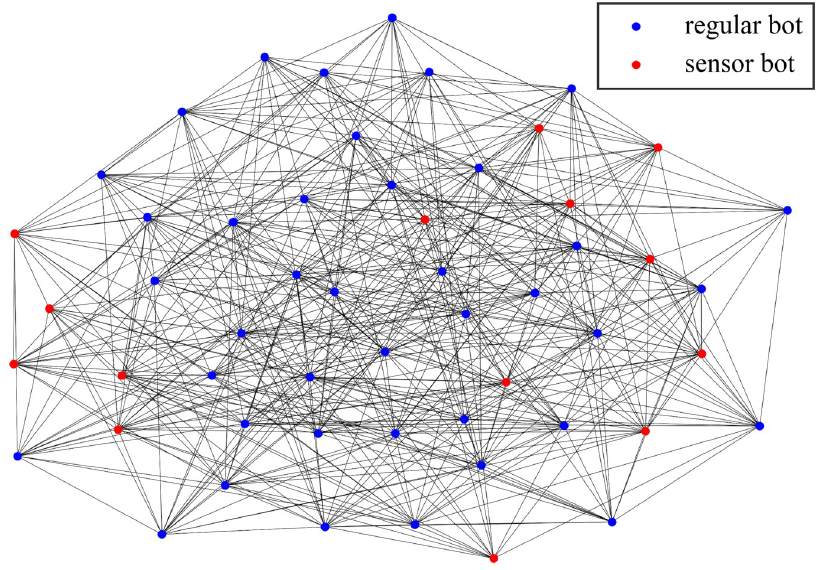
Fig 7. A network overview of the pre-constructed P2P botnet deployed on cloud platforms. overview of the simulated botnet, red dots represent sensor bots, and blue dots represent regu- lar bots. Fig 6 shows that all the bots are uniformly distributed.